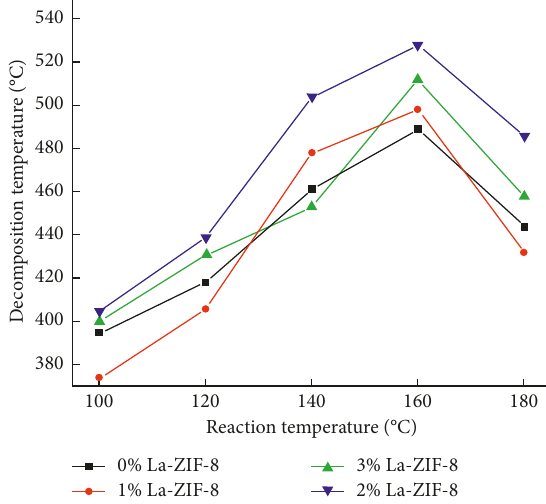
Figure 6: Thermal stability of ZIF-8 and